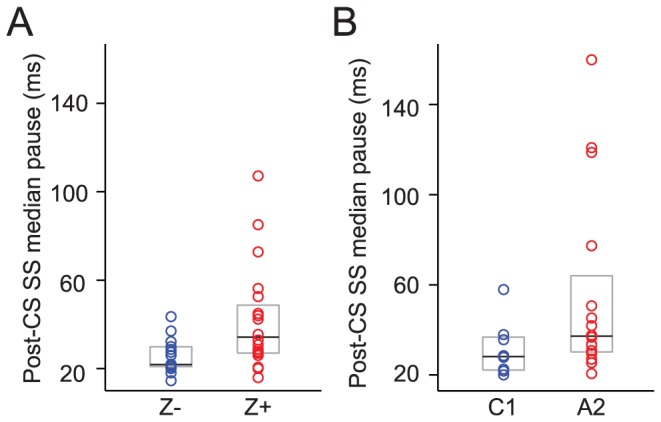
PCs in Z+ bands show longer absolute post-CS pauses in SS than those in Z− bands.The difference is consistent for both histologically (A) and physiologically (B) located PCs. Each circle represents the median duration of the pause of individual PCs in Z− bands or C1 zone (blue) and in Z+ bands or A2 zone (red). The black lines indicate the overall median across each group, and the grey boxes indicate the range from 25% to 75% of each distribution. Note that Z+ bands and A2 zone also consistently show higher variation than Z− bands and C1 zone.